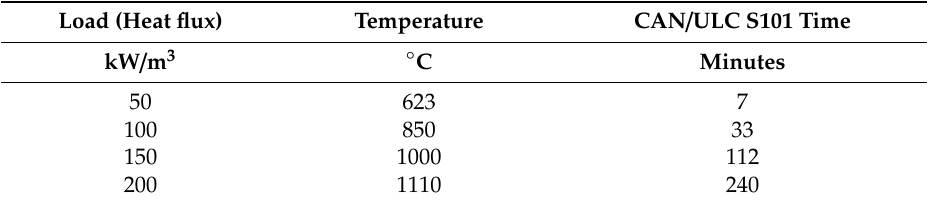
Table 1. Heat flux characterization.